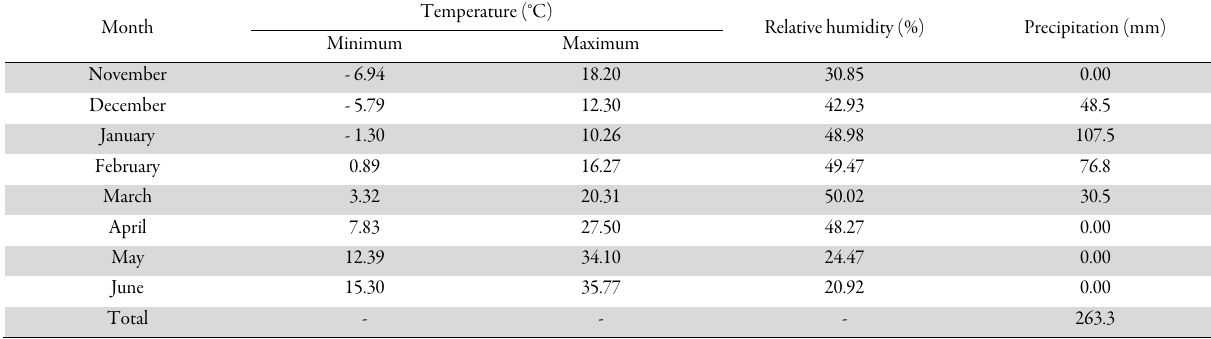
Table 2. Some weather parameters for the experimental site in 2010-2011 growing